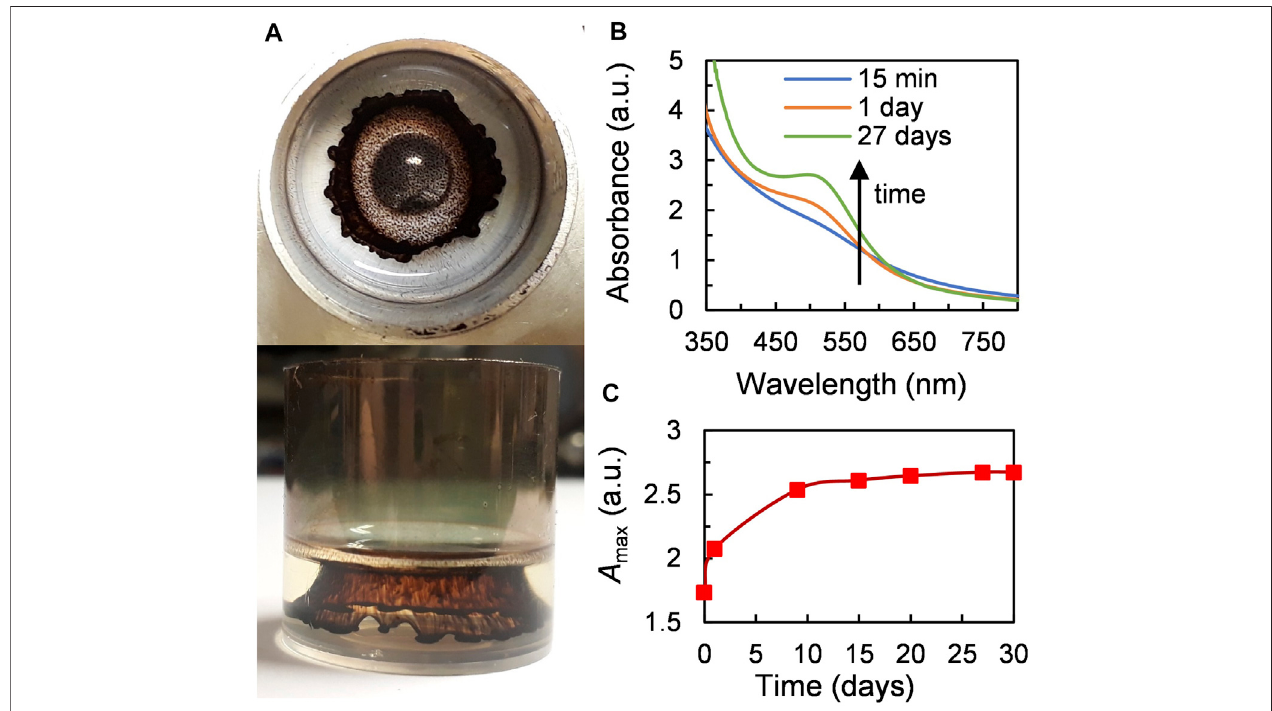
FIGURE 1 | A typical sample produced by magnetron sputtering of gold onto castor oil. (A) Photographs of the sample just after venting the vacuum chamber (experimental conditions: Ar pressure – 0.07 Pa, applied power – 80 W (488 V, 162 mA), sputter time – 5 min). (B) UV-vis spectra of the solution obtained after stirring the sample (time marks indicate the time after fi nishing sputtering). (C) Increase in absorbance at the maximum of SPR of Au NPs (505 nm) with